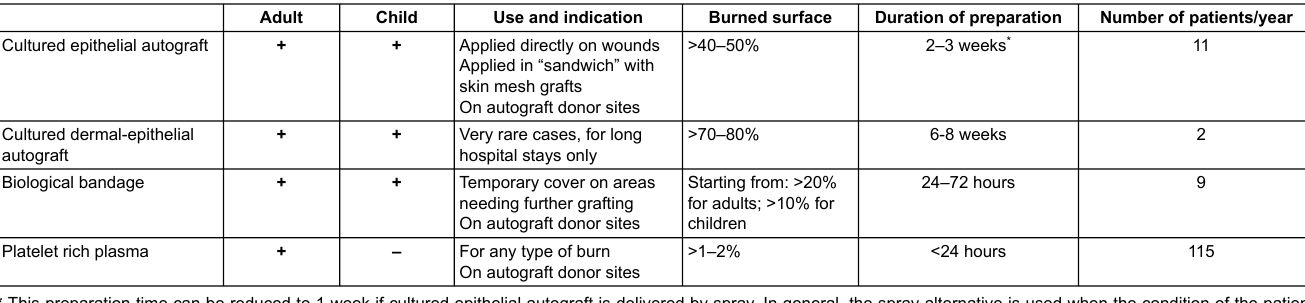
Table 2: Different indications for the use of cell therapies at the CHUV Burn Centre, as well as the average number of patient per year that benefited from each therapy for the past 5 years. The time delay before receiving a cell therapy varies depending on the type of treatment: the need for a cell culture step considerably prolongs the preparation time before transfer to the patient. Note that biological bandages and platelet rich plasma can be transferred within 24–72 hours and less than 24 hours, respectively, after prepara-